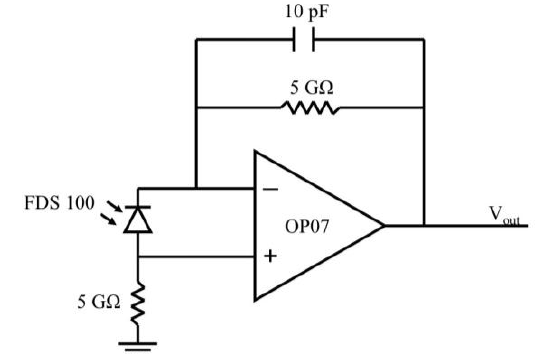
Figure 3 . Transimpedance amplifier using OP07 and 5 GΩ